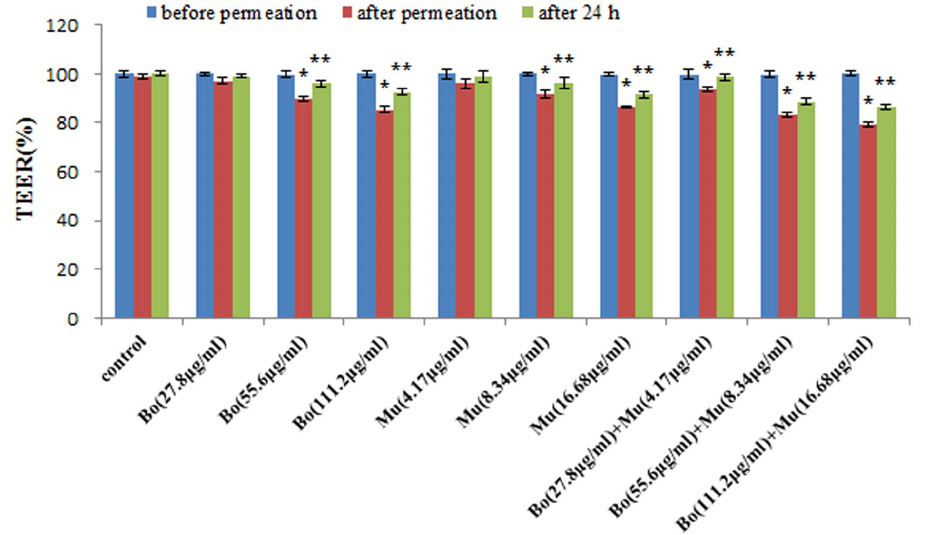
Figure 4. TEER of HNEC monolayer before permeation, after permeation, and after 24 h. Date are expressed as mean 6 SD ( n =3). * P , 0.05, TEER of after permeation compared with before permeation, ** P , 0.05, TEER of after 24 h compared with after permeation.